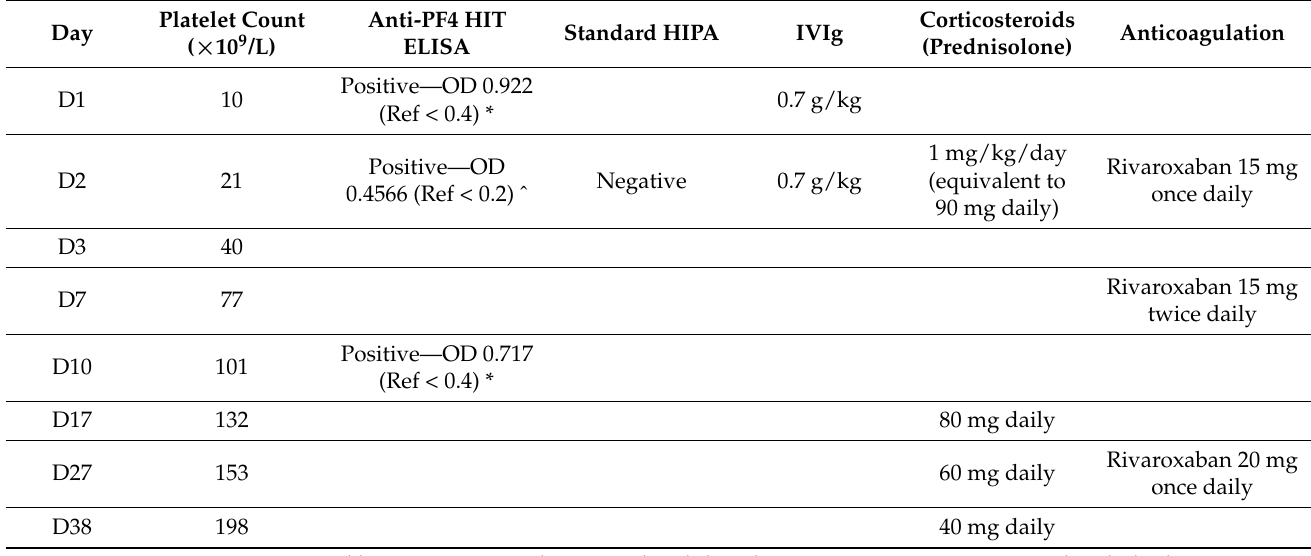
Table 1. Results of platelet count, anti-PF4 HIT ELISA and standard HIPA, and a summary of the treatment